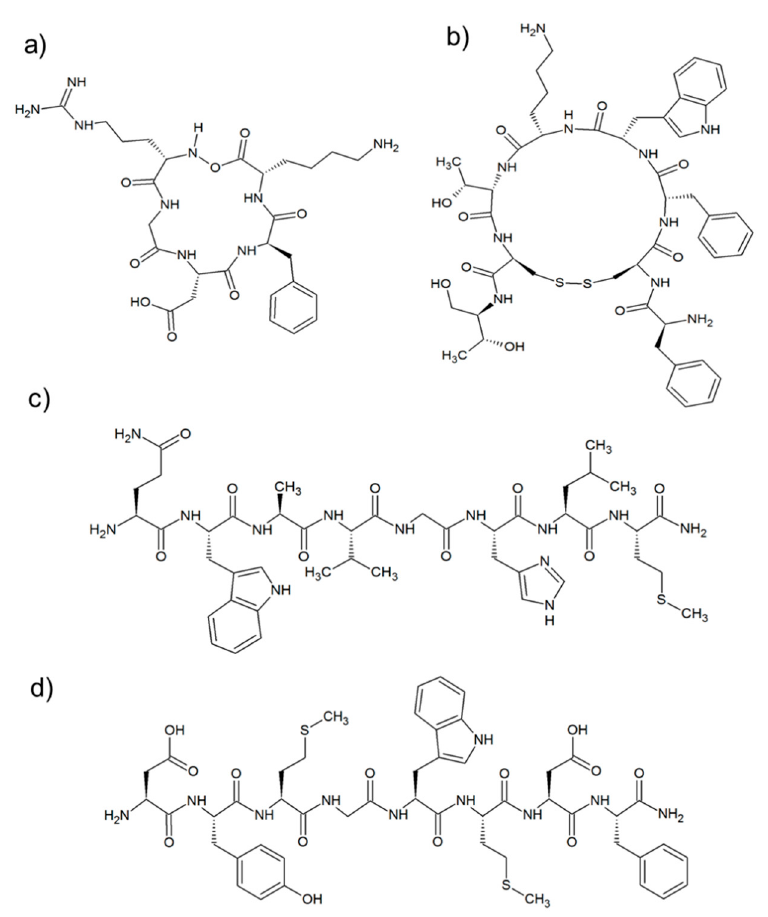
Figure 4. Structure of targeting peptide sequences: ( a ) c(RGDfK); ( b ) Otreotide[c(2–7)-FCFWKTCTol]; ( c ) [7–14]-Bombesin (H-QWAVGHLM-NH 2 ), and ( d ) CCK8(H-DYMGWMDF-NH 2 ).